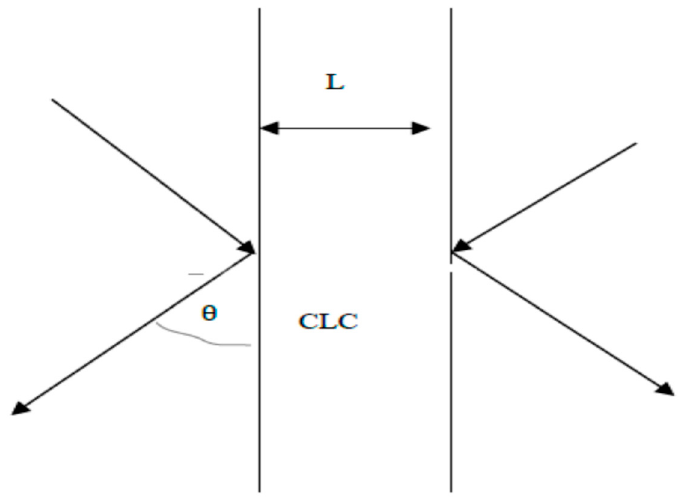
Figure 1. Schematic of a boundary problem for the localized conical edge mode (CEM).